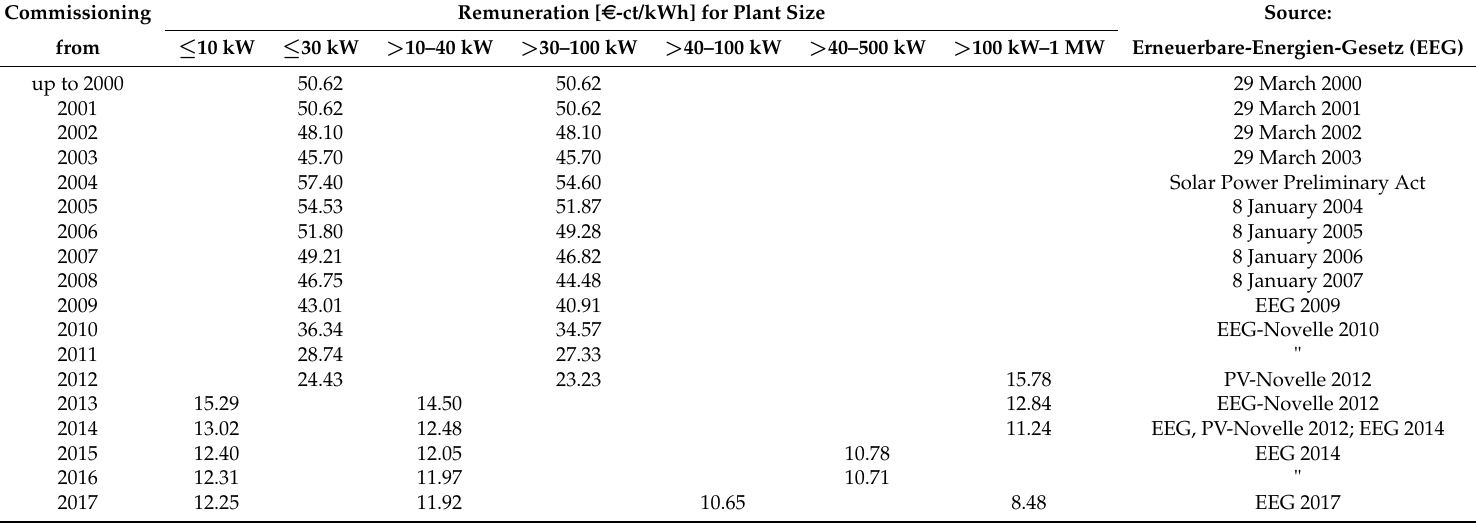
Table A3. Development of EEG remuneration for PV power plants of different